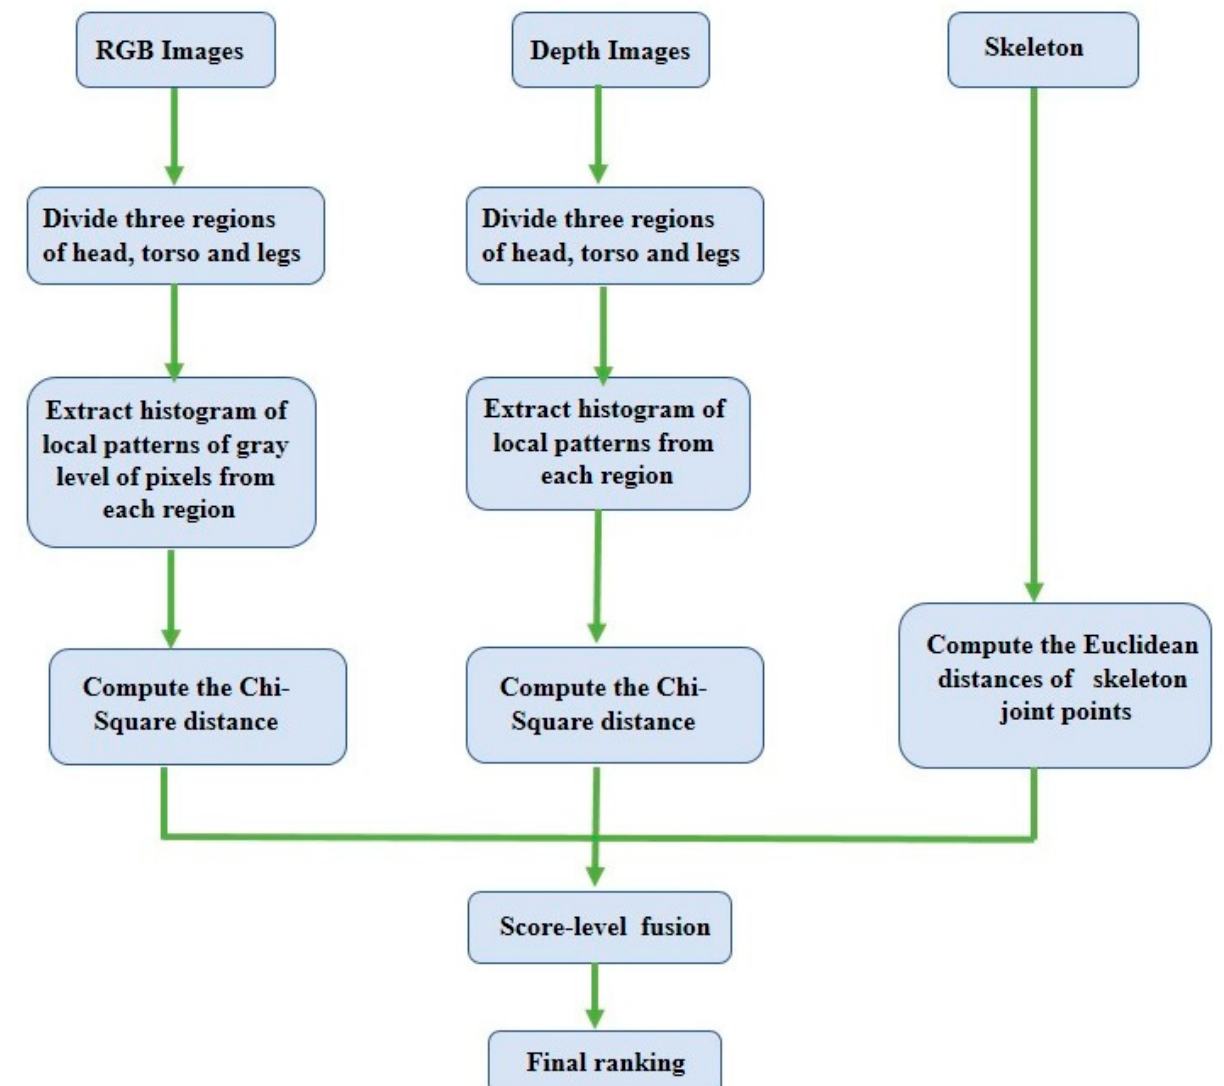
Figure 8. A flowchart of the RGB–depth–skeleton-based Re-ID.